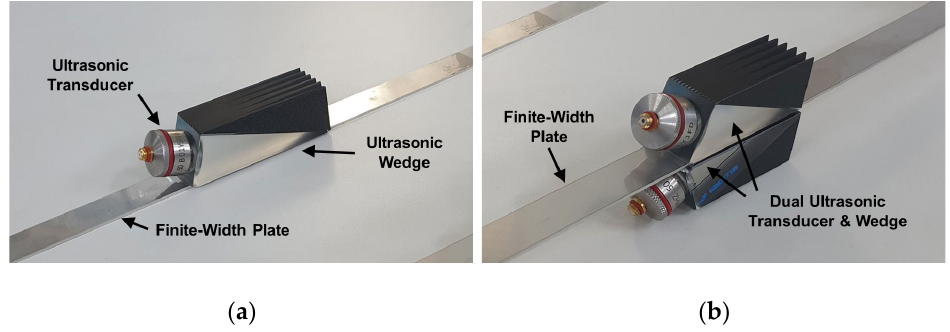
Figure 8. ( a ) Single wedge technique and ( b ) dual wedge